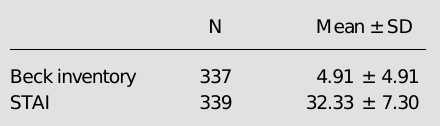
Table 5 - Mean results obtained through the Beck inventory and State-Trait Anxiety Inventory (STAI) (N =